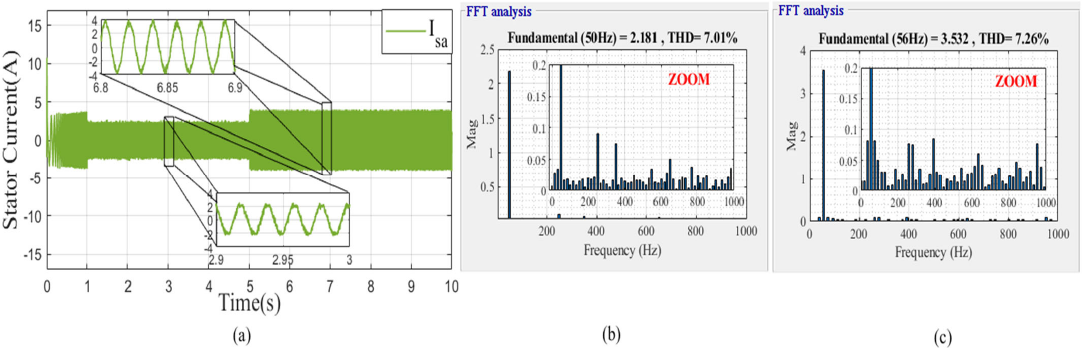
Figure 42. Performance with Cage bearing defect of IM with ANN ‐ DTC control: ( a ) rotation speed and ( b ) motor torque.